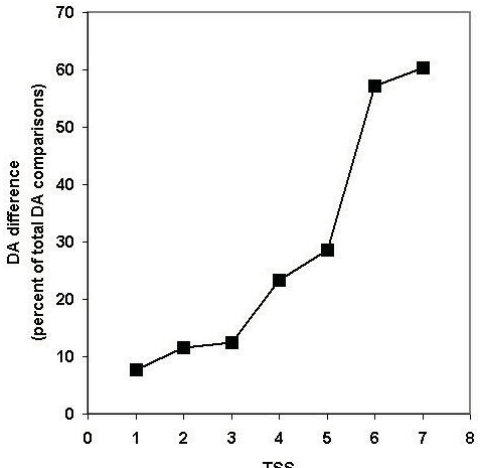
Figure 7. Analysis of the DA of clusters defined by strong component analysis of sequence similarity networks of human Swiss-Prot sequences. The numbers on the abscissa indicate the number of top-scoring matches included in the analyses (TSS = 1, .... TSS = 7) used to define paralogous clusters. The values of the ordinate show the percent of DA comparisons within clusters where the pairs compared differ in DA. (Since the number of pair-wise comparisons and computational time increased exponentially with the increase of TSS values, the figure shows only data for TSS = 1 – TSS =